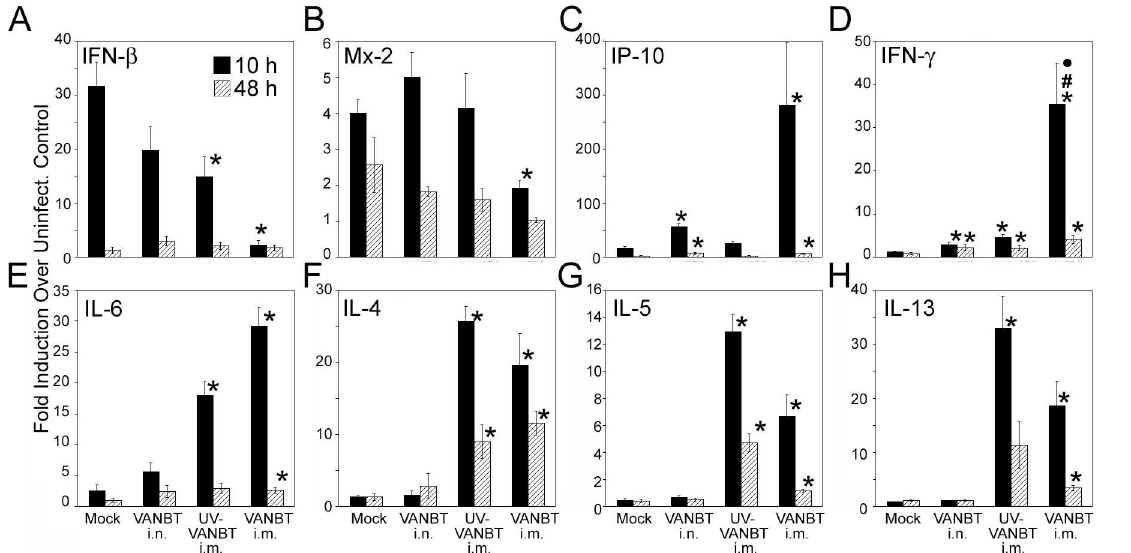
Fig 6. Intramuscular immunization with VANBT induces both Th1 and Th2 cytokines upon virus challenge. Female cotton rats were mock-immunized i.m. on day 0 and at 3 weeks, infected with VANBT on day 0, or immunized i.m. on day 0 and at 3 weeks with UV-VANBT, or VANBT, using 10 6 TCID 50 /100 μ l of virus. At 7 weeks, all animals were challengedi.n. with 10 6 TCID 50 of VANBT and sacrificed at 10 h or 48 h p.i. RelativemRNA expression profiles of IFN- β (A), Mx-2 (B), IP-10 (C), IFN- γ (D), IL-6 (E), IL-4 (F), IL-5 (G), and IL-13 (H) at either 10 or 48 h p.i. in the lung tissues were measured by qRT-PCR. Results were calculatedas fold-induction over uninfected(na ï ve) animals and expressed as geometric means ± SE. Results are representative of two independent experiments, n = 5. * p < 0.05 for each group compared with mock-immunized group, #p < 0.05 when VANBT/i. m. compared to VANBT/i.n. and ⦁ p < 0.05when VANBT/i.m. compared with